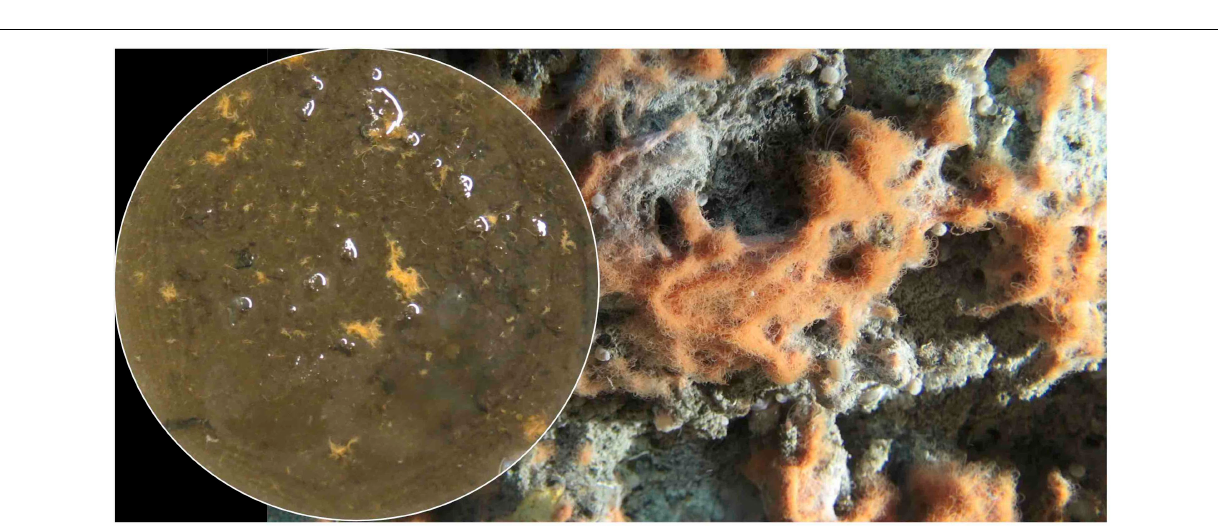
Frontiers in Microbiology |